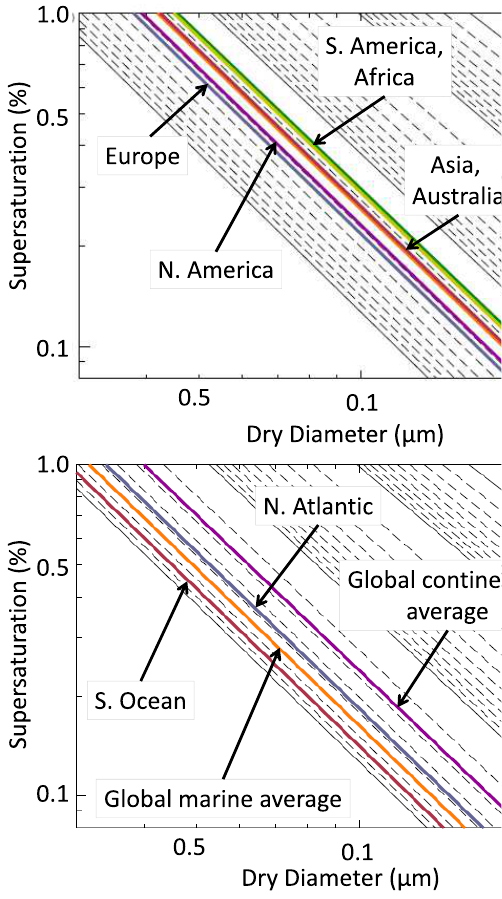
Fig. 7. The relationship between particle diameter and critical su- persaturations plotted as done by Petters and Kreidenweis (2007), but with the lines corresponding to the simulated regional mean PBL κ values